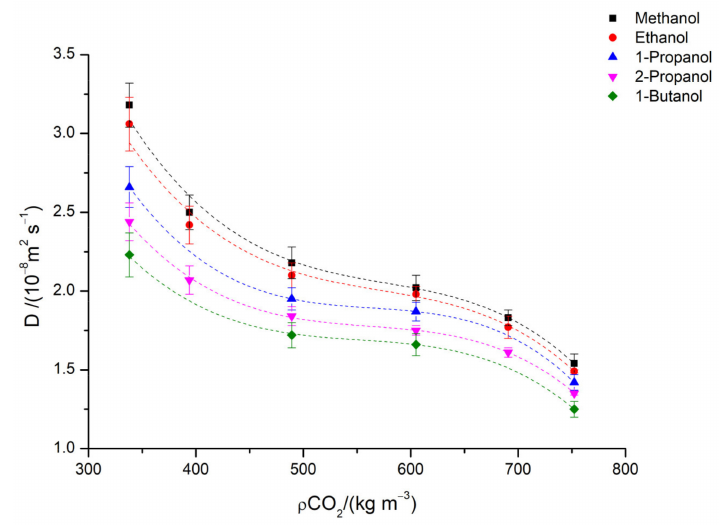
Figure 2. Diffusion coefficient for methanol, ethanol, 1-propanol, 2-propanol and 1-butanol in scCO 2 at p = 10.5 MPa and at different temperatures from 306.15 to 331.15 K. Dots are experimental values and dashed lines are the